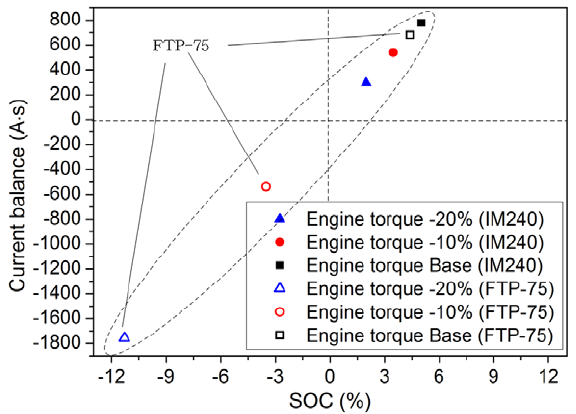
Figure 11. Current balance during IM240 and FTP-75 modes under conditions of reduced engine-torque.